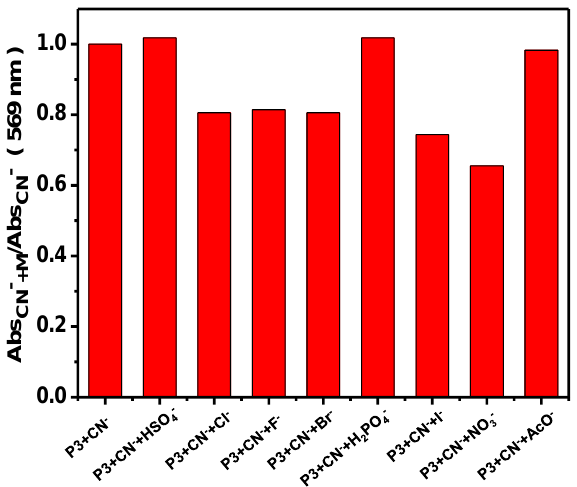
Figure 8. Changes in the UV-Vis absorbance at 569 nm of P3 ([RU] = 30 µM) containing 20 equiv. of CN - anions upon the addition of 20 equiv. of other competing anions in THF/H 2 O (98:2, v/v ).